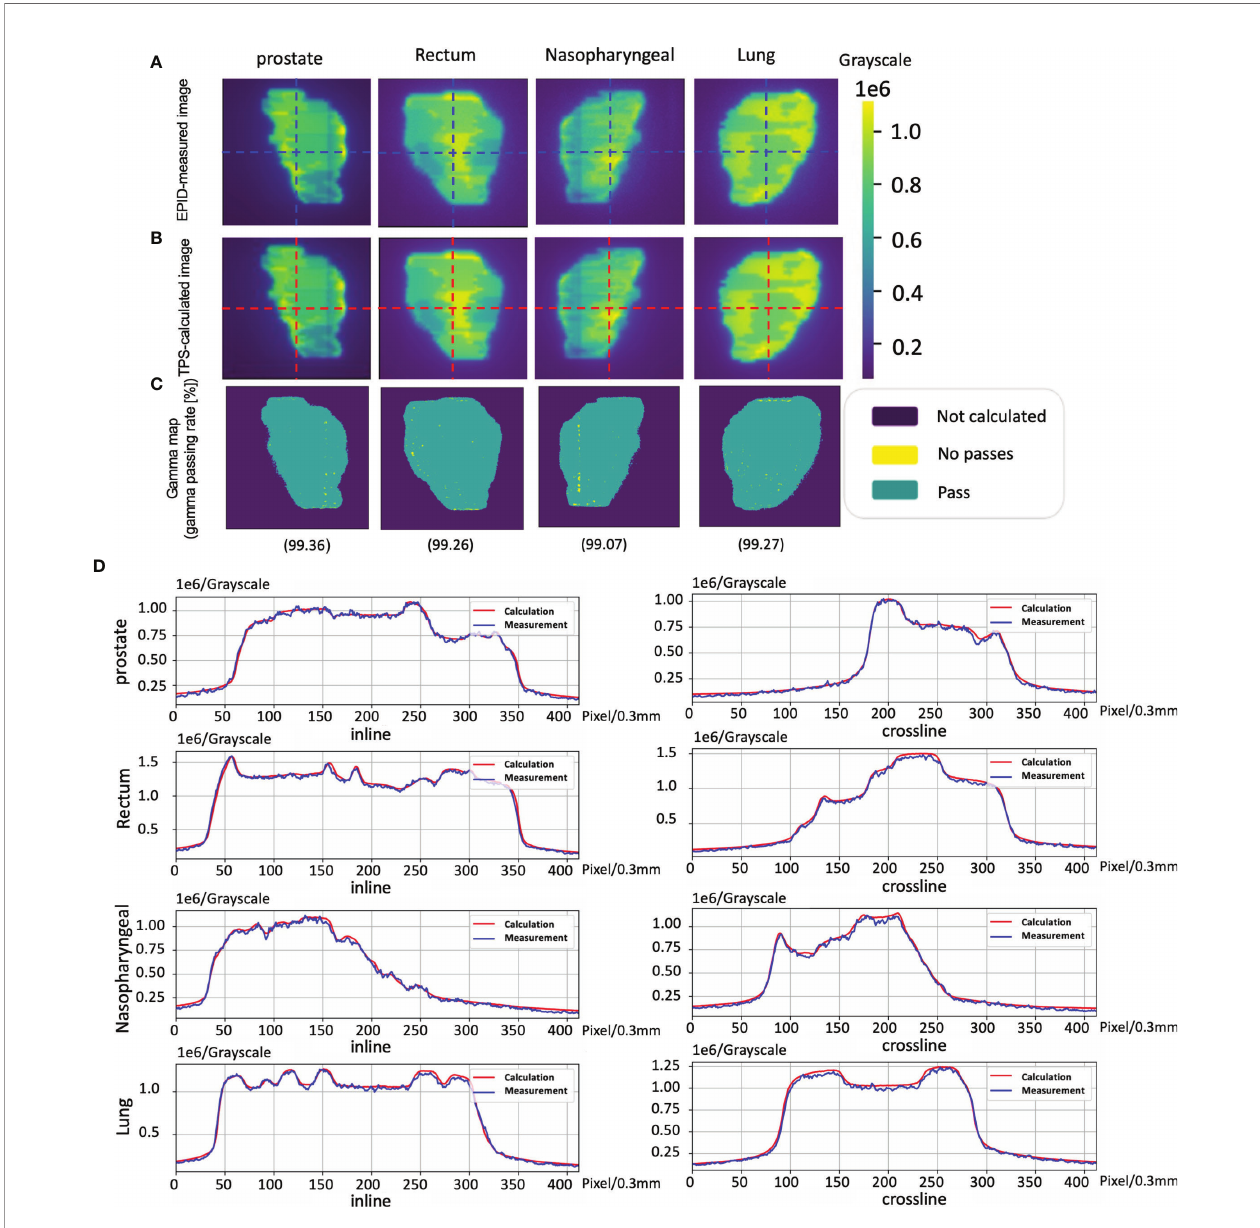
FIGURE 5 | The cases of pretreatment quality assurance (QA). (A) An electronic portal image device (EPID)-measured image. (B) A phantom model-based calculated image. (C) The corresponding Gamma analysis results. (D) Pro fi les representing inlines and crosslines are shown in panels (A, B)